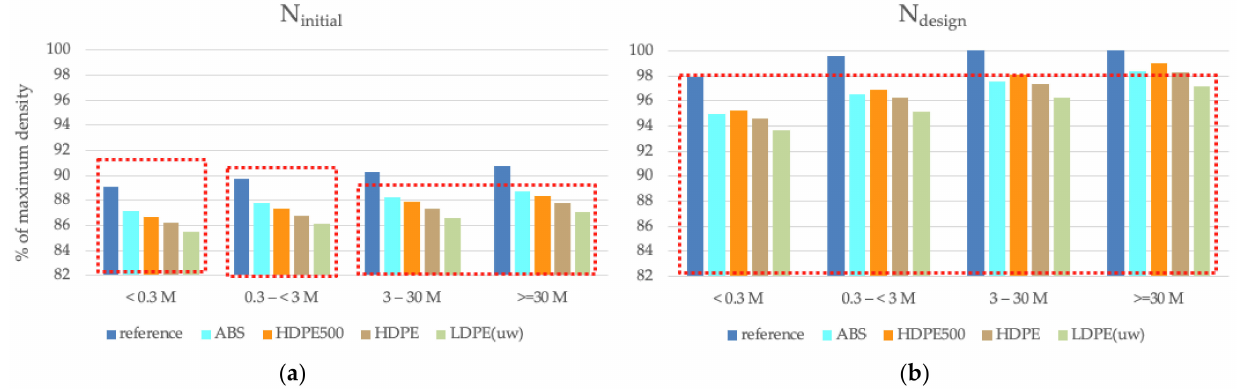
Figure 15. Comparison of the workability measured in gyratory compaction tests with the SUPER- PAVE limits for ( a ) N initial and ( b ) N design